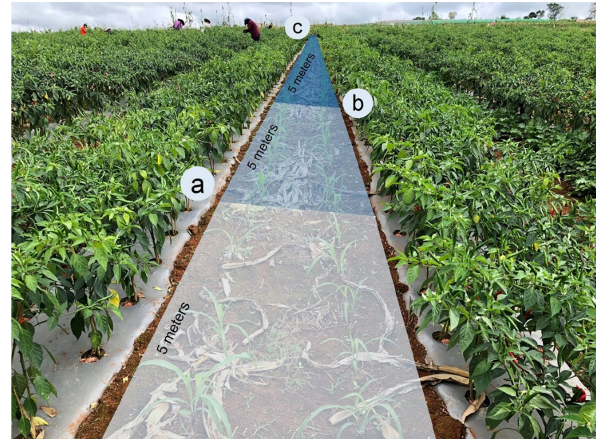
Figure 2: Pepper plantation area where the pepper samples used in this study were collected. The diagram shows how the pepper samples were randomly collected from the field as shown, for example, of the collecting points a, b, and